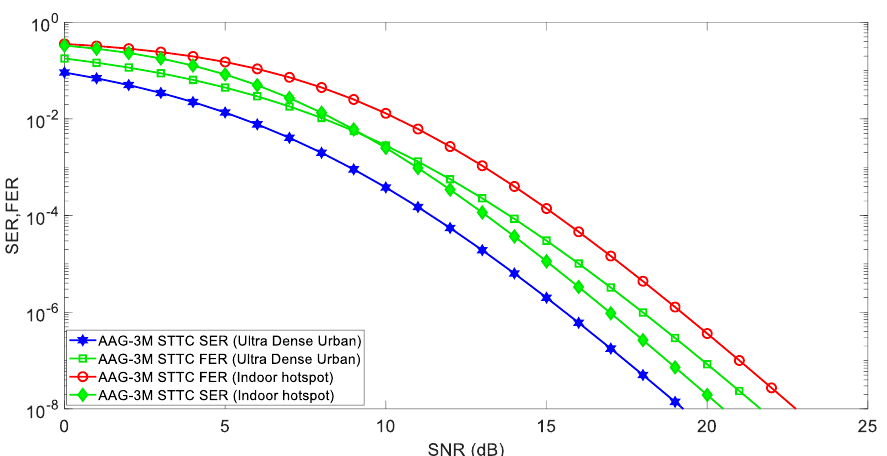
Figure 4. Comparison of urban, suburban, and rural deployment for AAG-3M STTC in terms of FER and SER.